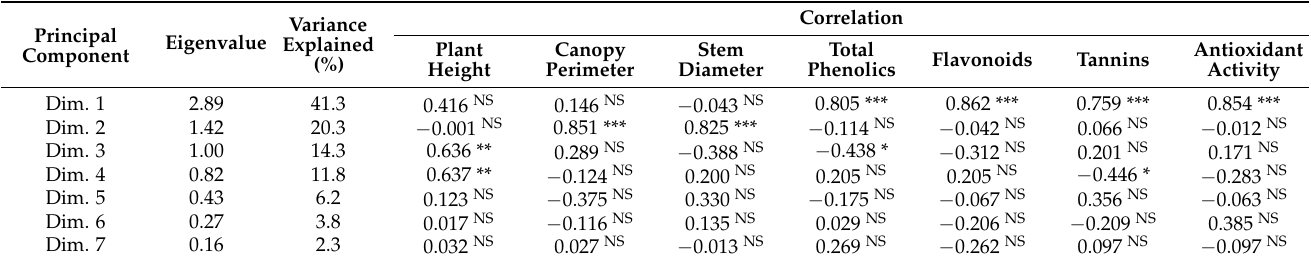
Table 4. Eigenvalue, percent of explained variance and correlation with the original variable of the seven principal components (Dim.) extracted.